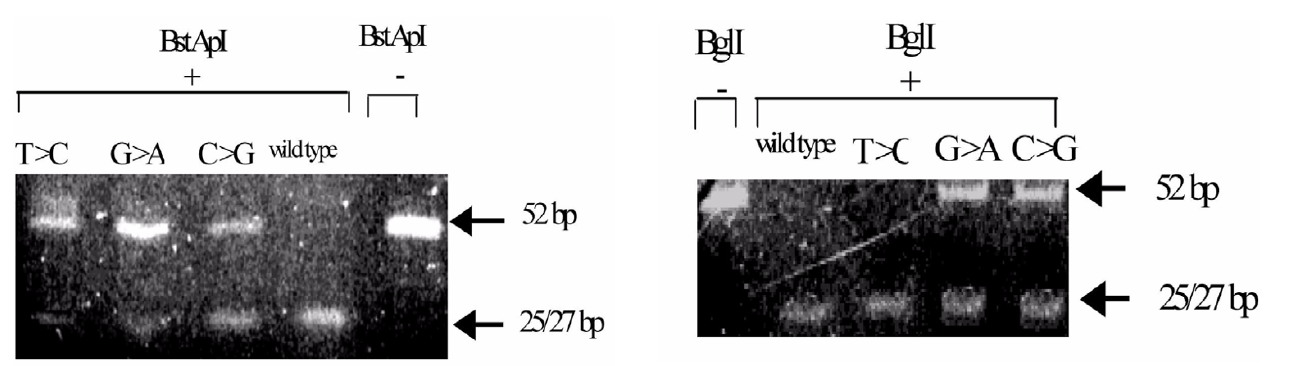
Figure 2 Check of the integrity of codon 634 with the BstApI enzyme. DNA samples were amplified using the forward and reverse primers shown in figure 1. The PCR product was incubated in the presence (lane 1–4) or absence (lane 5) of BstApI. The restriction fragments were run in a non-denatur- ing 10% PAGE. Lane 1: mutation in the first base of the 634 codon (T>C); lane 2: mutation in the second base of the 634 codon (G>A); lane 3: mutation in the third base of the 634 codon (C>G); lane 4: wild type 634 codon; lane 5: wild type 634 codon without enzyme incubation. Both alleles are com- pletely cut by the enzyme in the wildtype codon, which means that the codon is correct. In the rest of the samples, the product is not completely cut, which reveals that one allele is mutated at one of the three bases of codon 634.